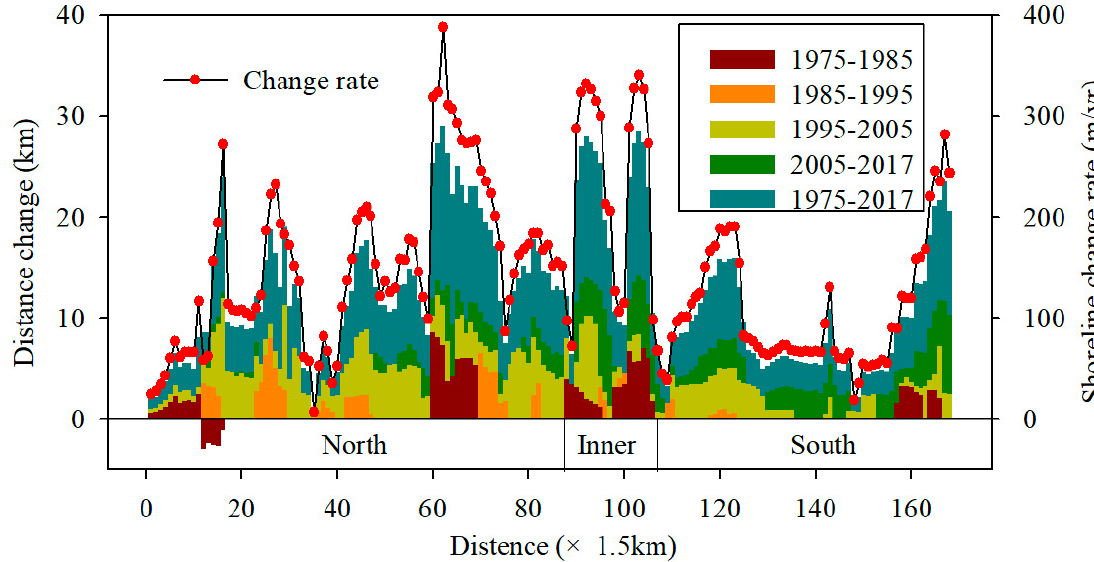
Figure 7. Spatial changes in the shoreline of the coastal tidal flats in the modern RSRs.